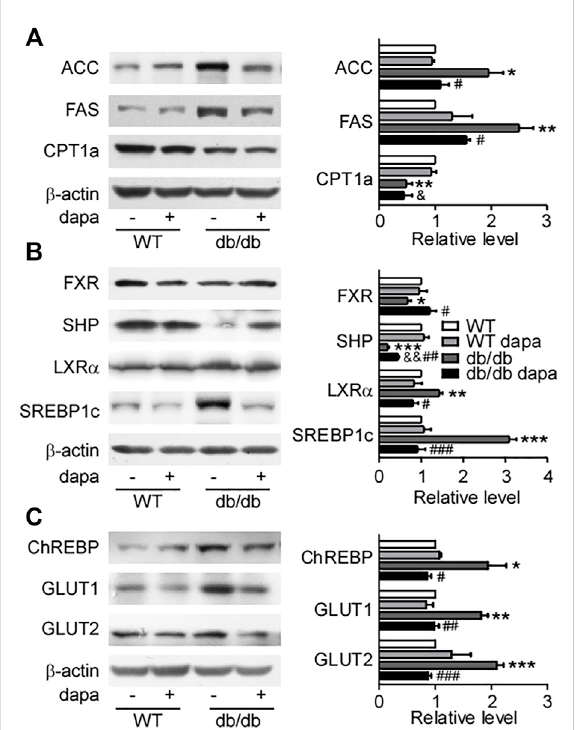
binding protein; GLUT1 = glucose transporter 1; GLUT2 = glucose transporter 2.